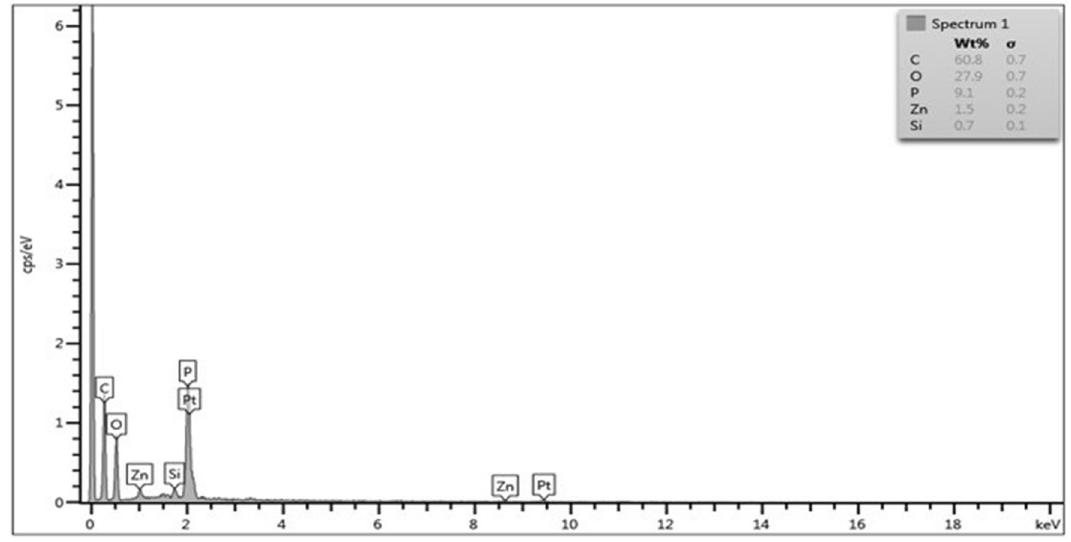
Fig. 4 Different elements observed scanning electron microscopic analysis of activated carbon made from banana peels